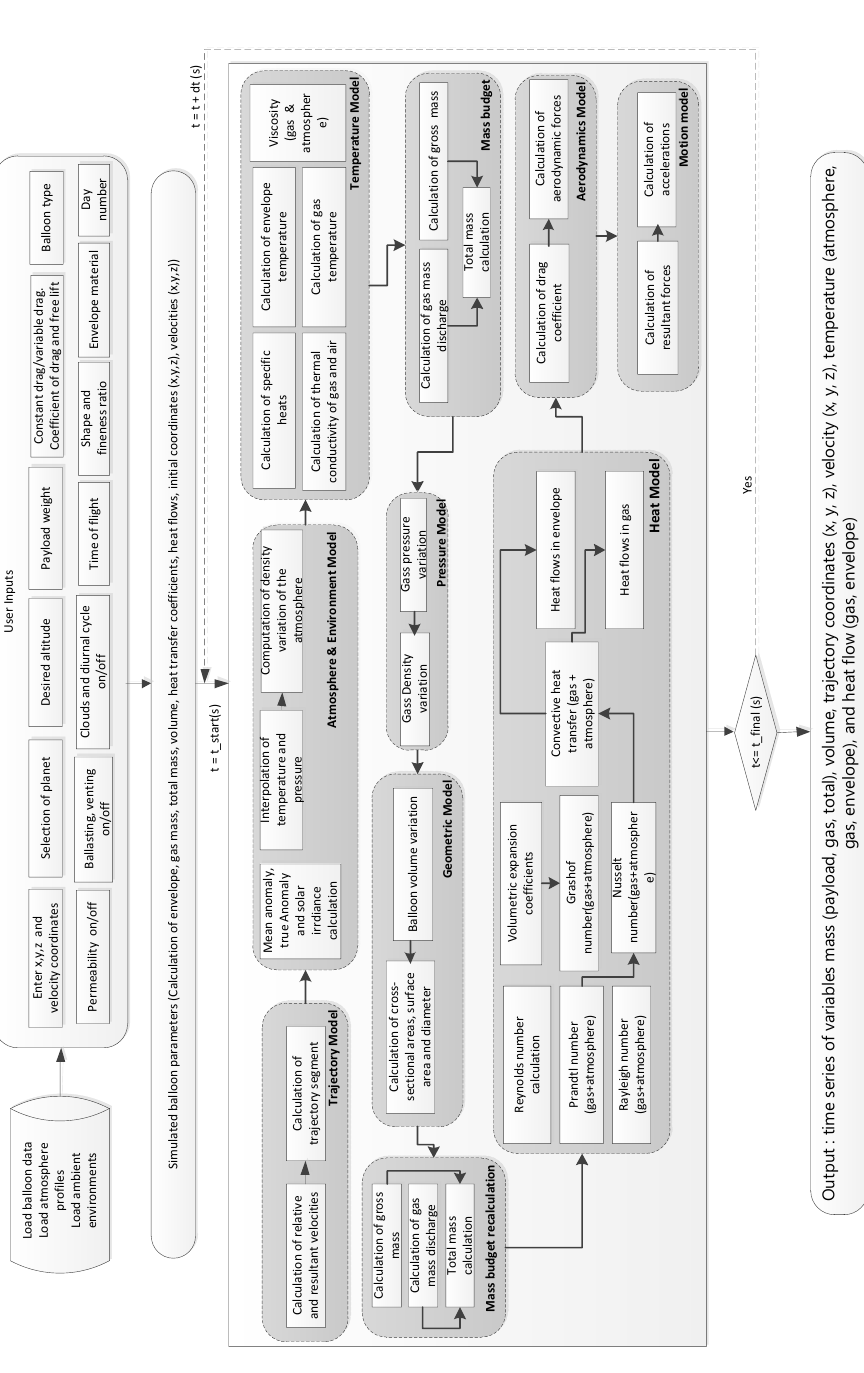
Figure 3. Simulation architecture for balloon ascent estimation. The modules which constitute the physical simulation are shown together with their interlinked data connections as well as the databases, inputs, and